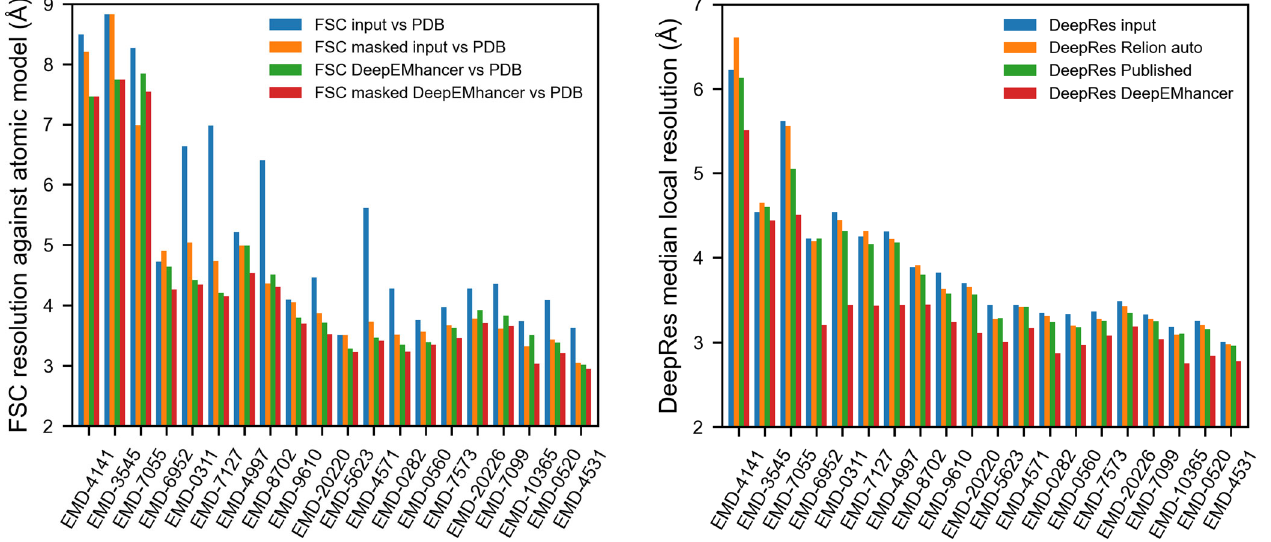
in Fig. 1, the FSC resolution obtained for the post-processed maps tends to be better than the values computed for the input independently of the mask application (green and red bars vs orange bar), which implies that the masking effect is of high- quality, as the resolutions for the unmasked DeepEMhancer results tend to be better than the ones for the masked input maps.